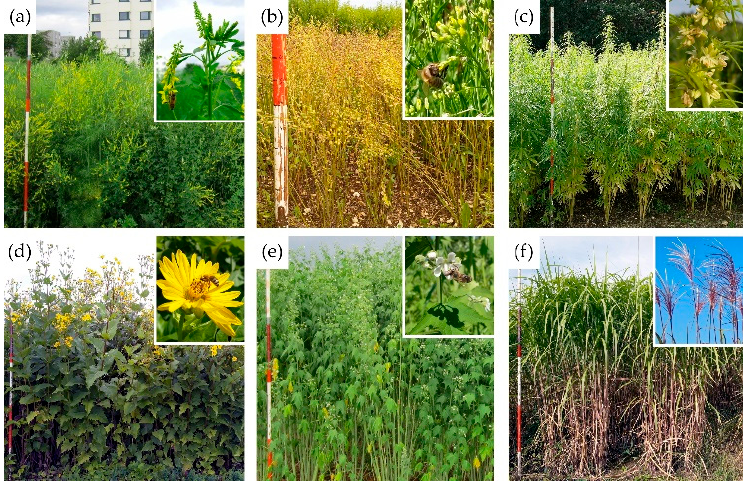
Figure 1. Impressions of some promising bioenergy / multi-purpose crops and their inflorescences: ( a ) yellow melilot ( Melilotus o ffi cinalis L.) as part of a wild plant mixture for biogas production (‘BG90’, Saaten Zeller GmbH & Co. KG, Eichenbühl, Germany), ( b ) camelina ( Camelina sativa L. Crantz), ( c ) hemp ( Cannabis sativa L.), ( d ) cup plant ( Silphium perfoliatum L.), ( e ) Virginia mallow ( Sida hermaphrodita L. Rusby), and ( f ) miscanthus ( Miscanthus × giganteus Greef et